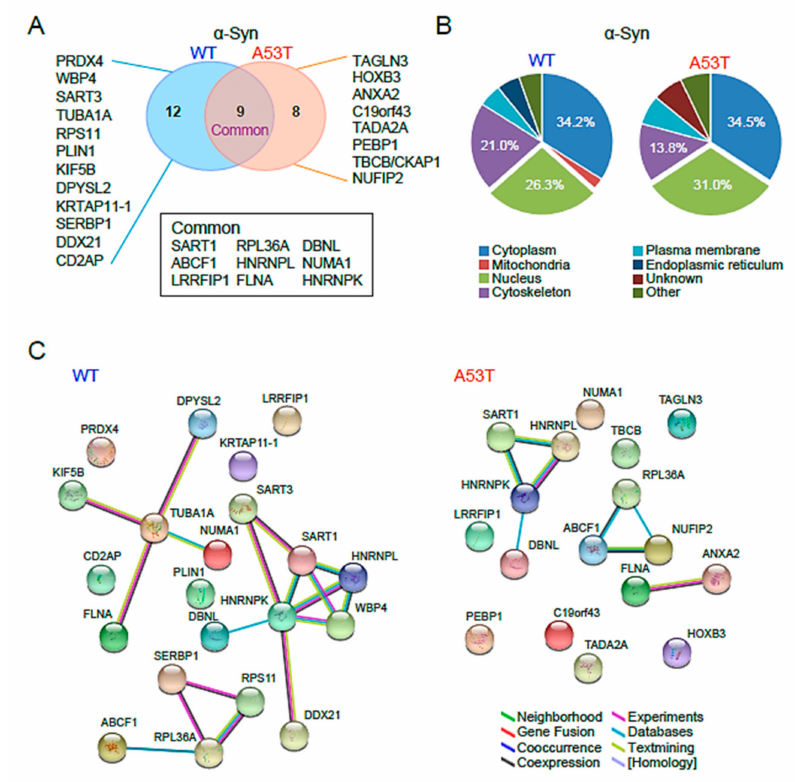
Figure 2. Proteomic analyses of α -syn WT and A53T interactors. ( A ) α -Syn WT and A53T interactors were identified via mass spectrometry following the BioID pulldown assay. ( B ) Pie chart showing the physiological relevance of α -syn interactors. ( C ) Proteins interacting with α -syn WT or A53T were analyzed using functional clustering. Biological pathway clusters enriched in the proteome of differentially expressed genes are shown. Line color annotation: green, neighborhood; red, gene fusion; blue, co-occurrence; black, co-expression; pink, experiments; light blue, databases; light green, text mining; light purple,